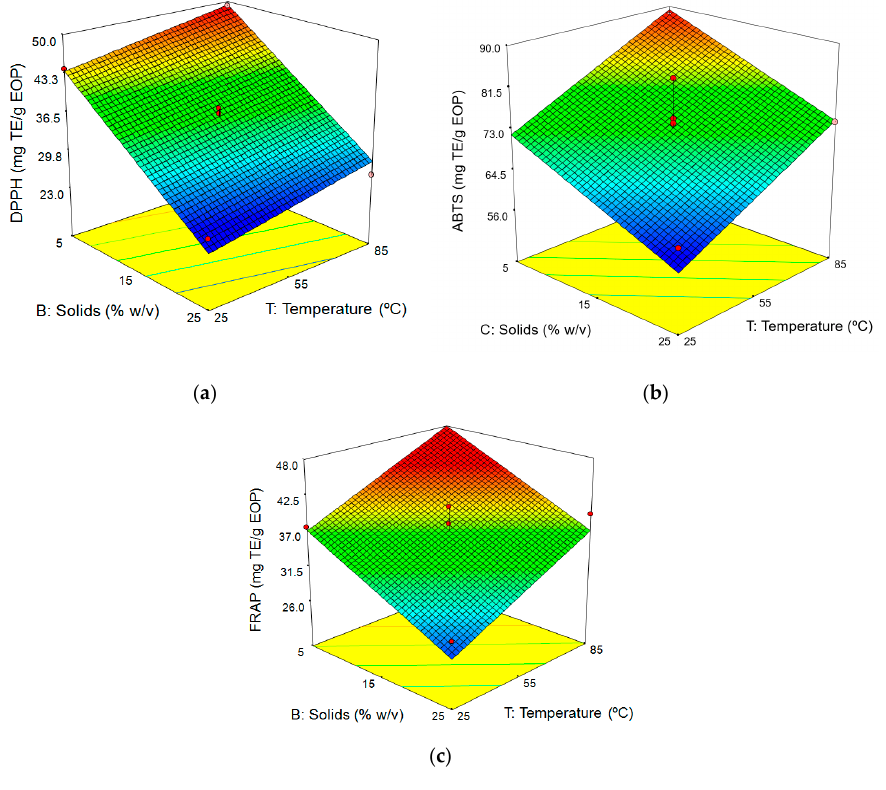
Figure 2. Response surfaces for ( a ) DPPH ( b ) ABTS, and ( c ) ferric reducing power (FRAP) assays as a function of temperature and solid loading (extraction time: 60